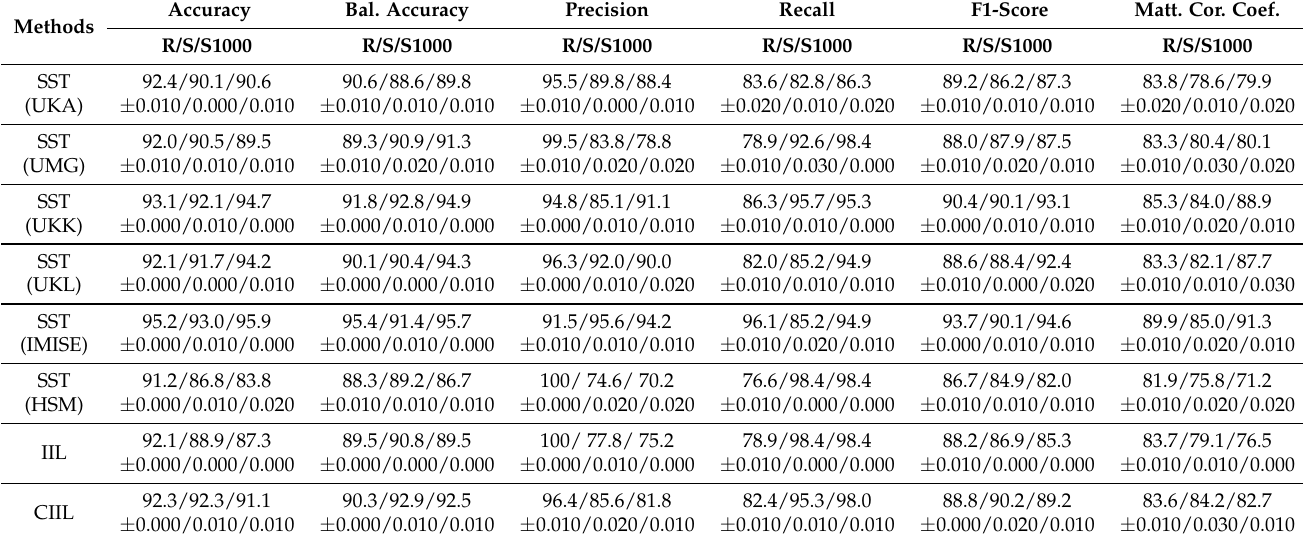
Table 3. Results in non-IID setting (equally-sized and unbalanced class distribution). The meaning of the abbreviations are: real-world data (R), synthetic data (S) and synthetic data with the generation size of 1000